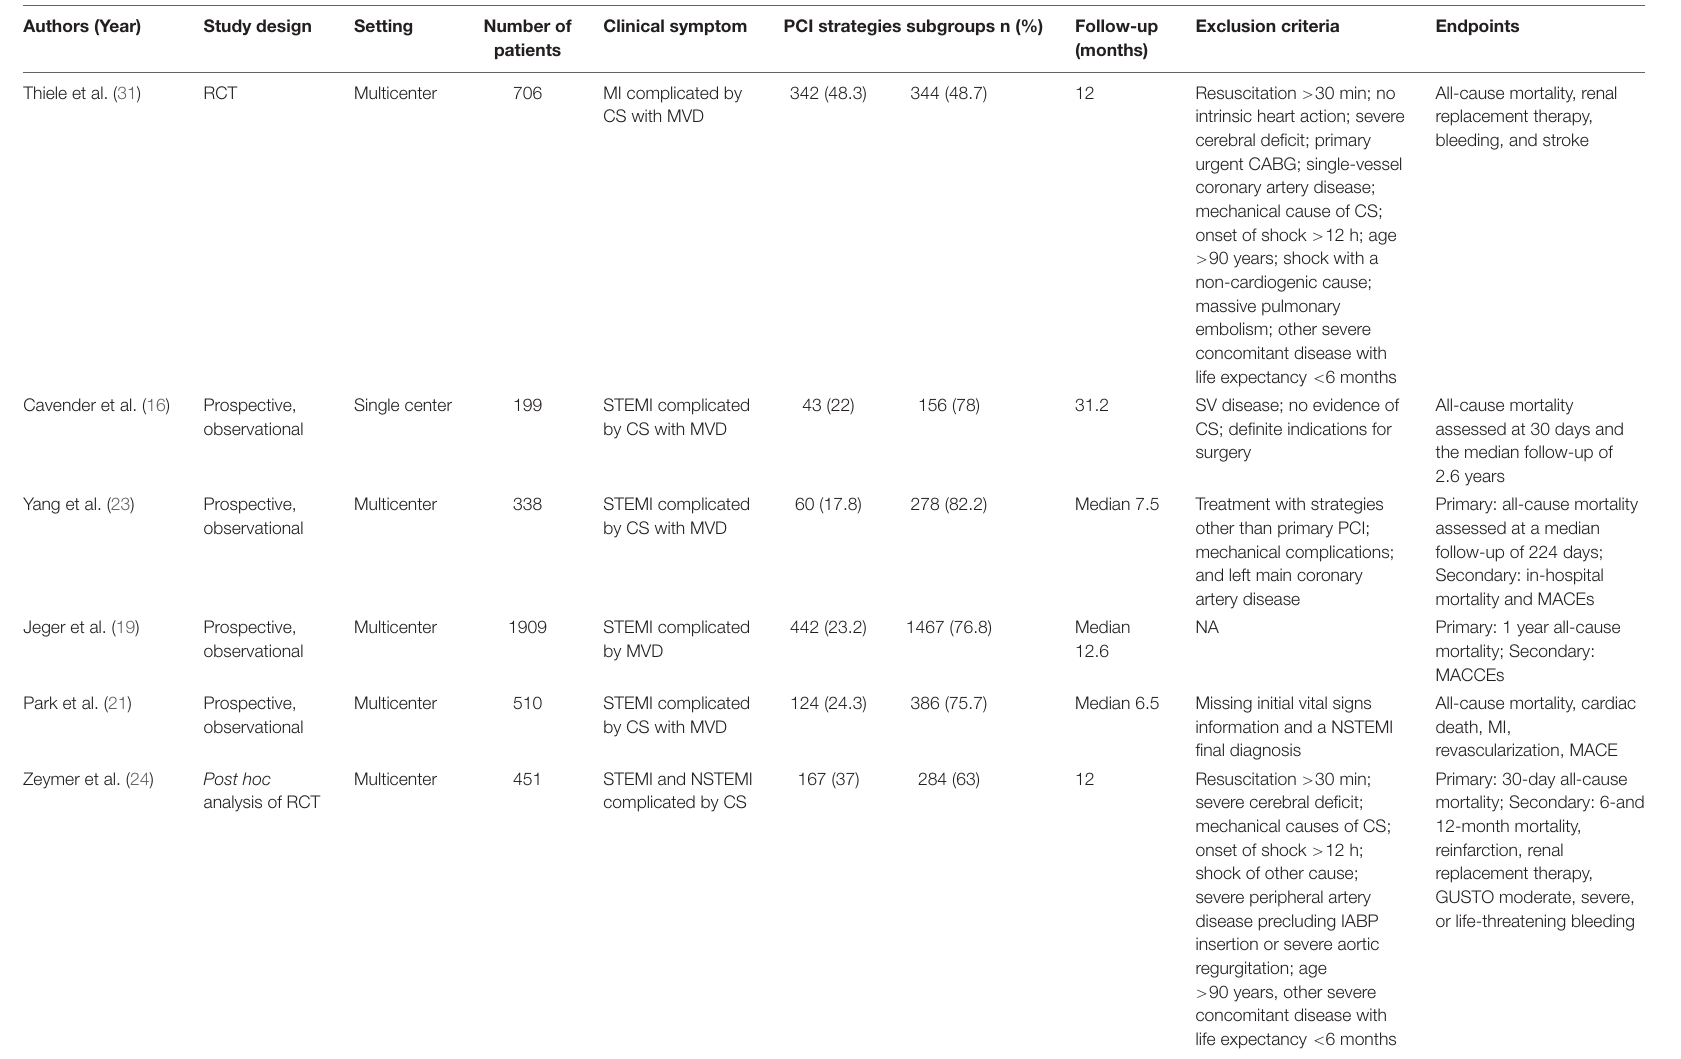
TABLE 1 | Summary characteristics of included studies in the